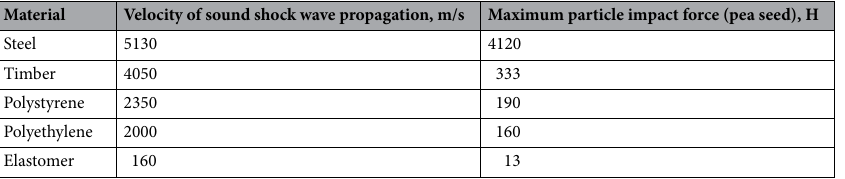
Table 1. Impact force of seeds on surfaces made of various